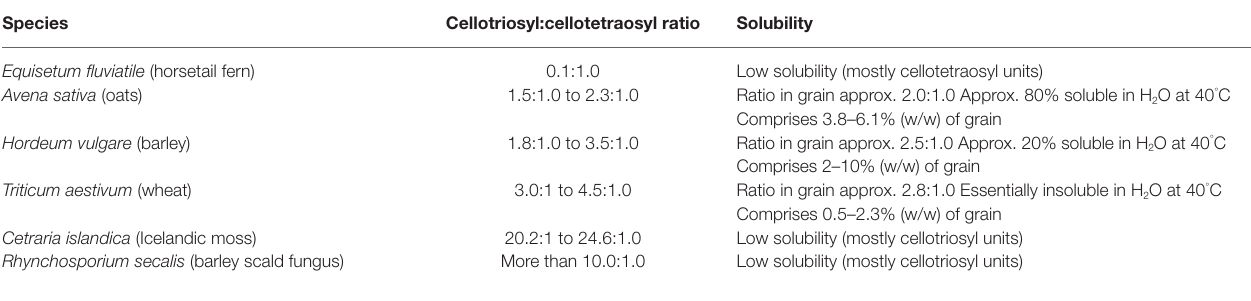
TABLE 2 | Effects of (1,3;1,4)- β -glucan fine structure on solubility. Species Cellotriosyl:cellotetraosyl ratio Solubility Equisetum fluviatile (horsetail fern)